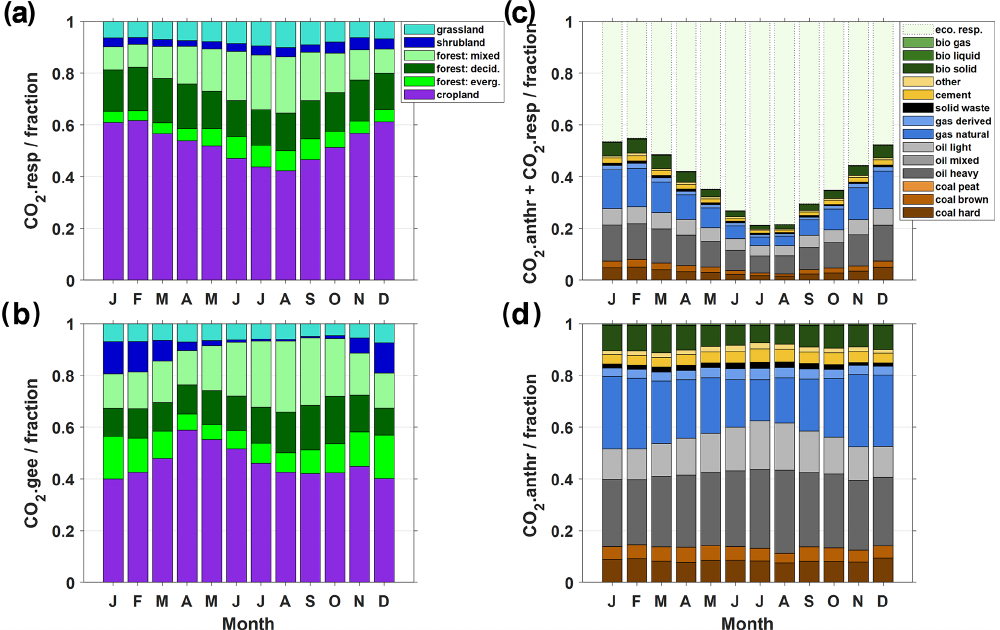
Figure 2. Simulated regional contributions to the CO 2 concentrations at JFJ (multi-annual monthly means of 3-hourly simulations, 2009– 2017, STILT-ECMWF). (a) Gross ecosystem respiration per vegetation type (CO 2 .resp), (b) gross ecosystem exchange (uptake) per vegeta- tion type (CO 2 .gee), (c) CO 2 .anthr and CO 2 .resp, (d) CO 2 .anthr per fuel-type. Maps of anthropogenic fluxes and vegetation distribution are provided in Figs. S1 and